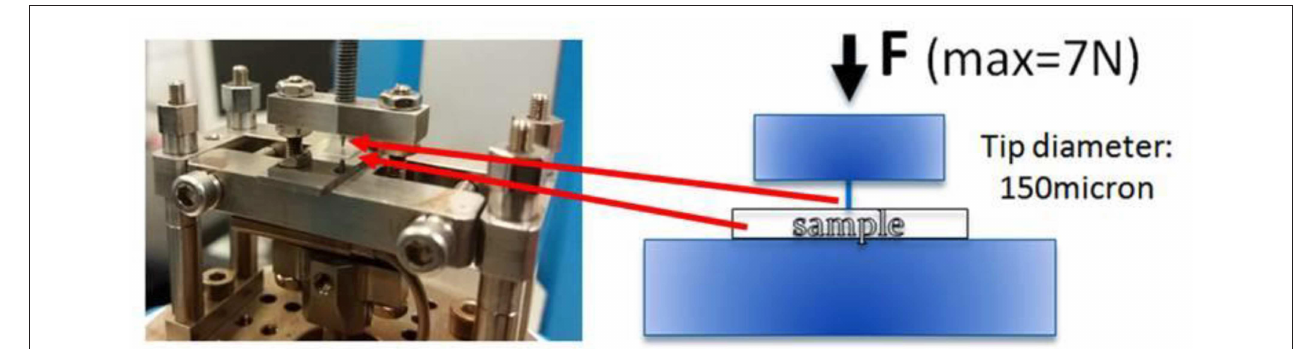
FIGURE 2 | Assembly for penetration test and scheme of the test.